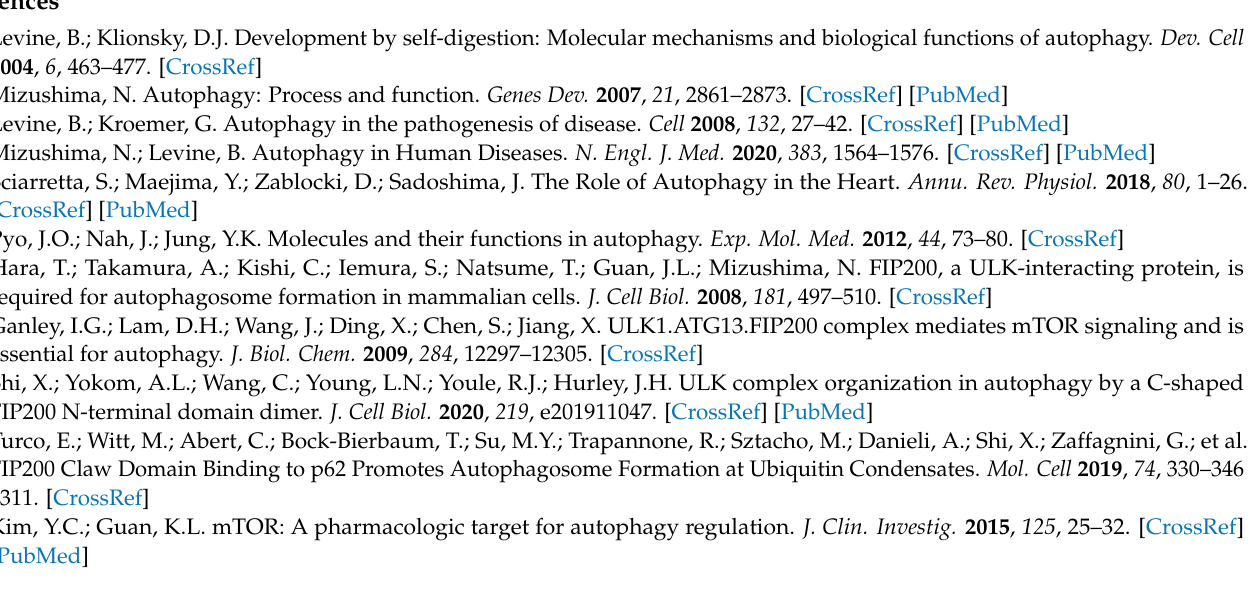
Figure S3: MS assay for E3 ligases of